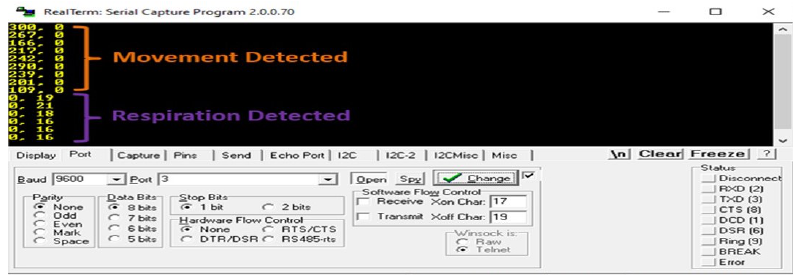
Figure 4. Visualizing the UWB data output showing the movement and breathing data. The visual- ization is made possible using the RealTerm Serial capture program 2.0.0.070 version installed in the host computer. The unit of the breathing data is breaths per minute (bpm).